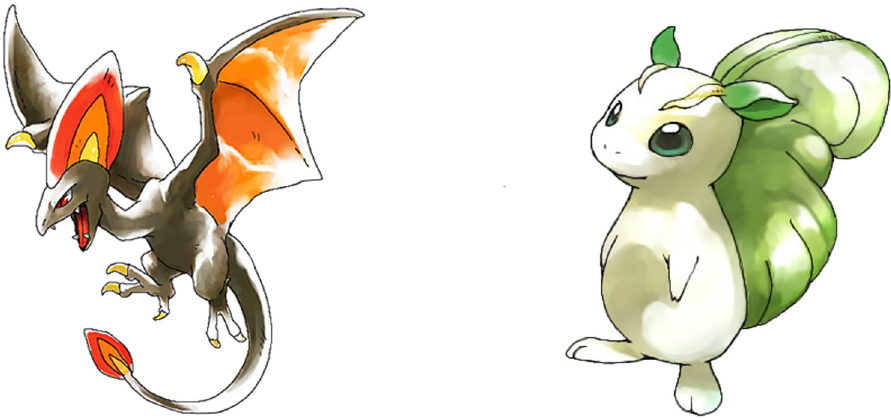
Figure 1: A sample pair of Pokémon pictures used in the experiment. Left = fl ying type; right = normal type. Sixteen pairs were created and used in the experiment. Due to copyright issues, not all of them can be reproduced in the article, but they can be made available upon request for the sake of replication, provided that the artist gives an approval to do so.